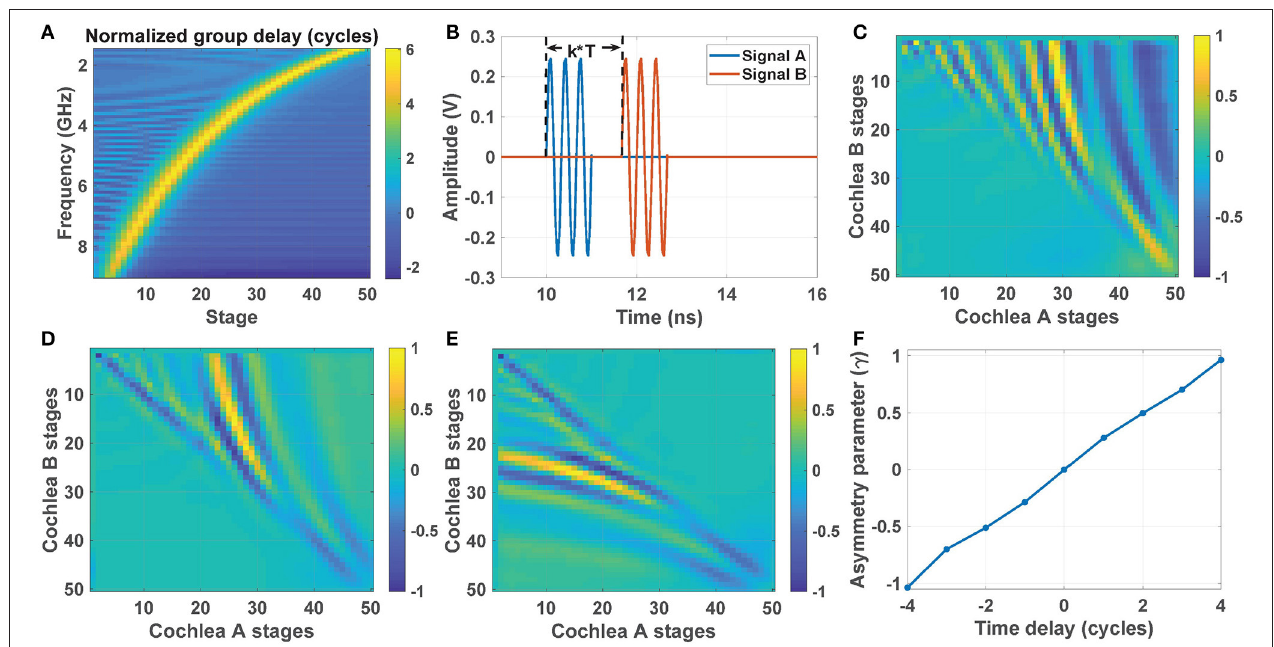
FIGURE 7 | (A) Normalized group delay (in cycles) of our cochlear model as a function of input frequency and stage number n . (B) Pulsed input signals A and B at 3 GHz with an ITD of k cycles; here T is the RF period. The corresponding cross-correlogram matrices for (C) k = 5, (D) k = 3, and (E) k = − 3. (F) Estimated asymmetry parameter γ as a function of the time delay (i.e., ITD) in cycles.